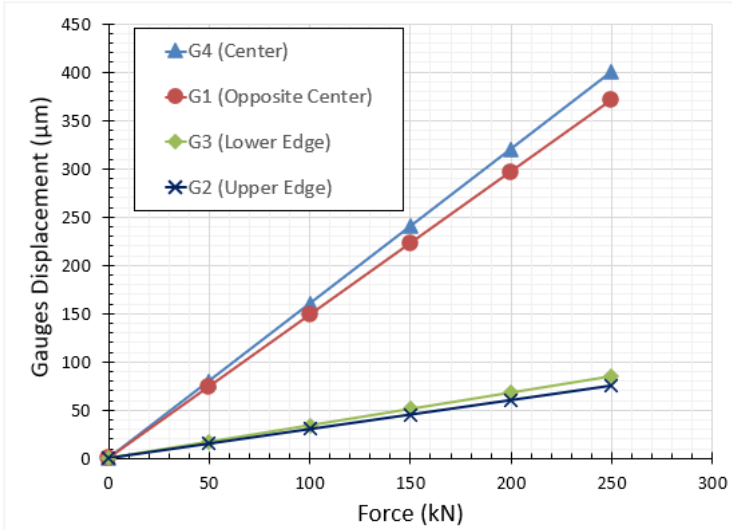
Figure 7. Steel ring calibration test; strain displacements were recorded by four gauges, fixed on the outer wall of the steel vessel (see Figure 2b), as a function of the applied vertical force.